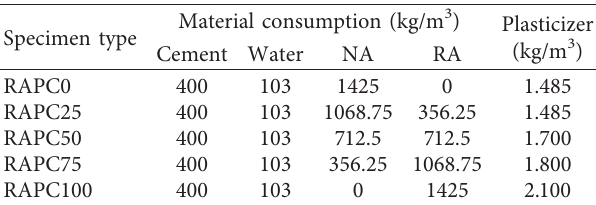
Table 2: Mixture proportion of RAPC (kg/m 3